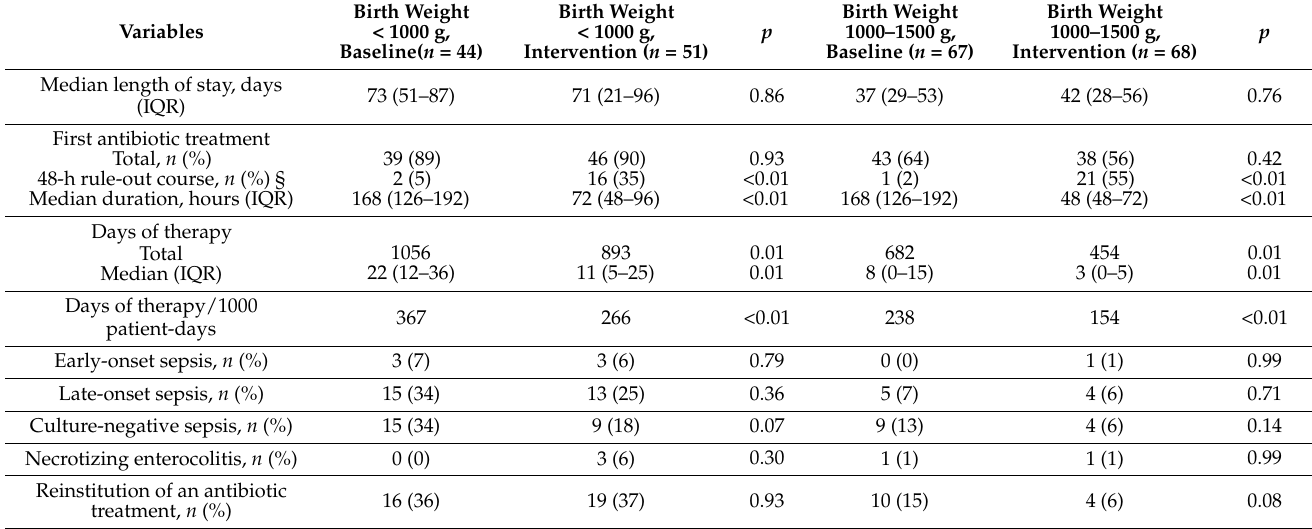
Figure 1. Antibiotic use by drug at baseline and in the intervention period. Baseline, blue columns; intervention period, red columns. DOT, days of therapy. Table 2. Length of stay, antibiotic use, sepsis, necrotizing enterocolitis, and reinstitutions of antibiotic treatments in both periods according to birth